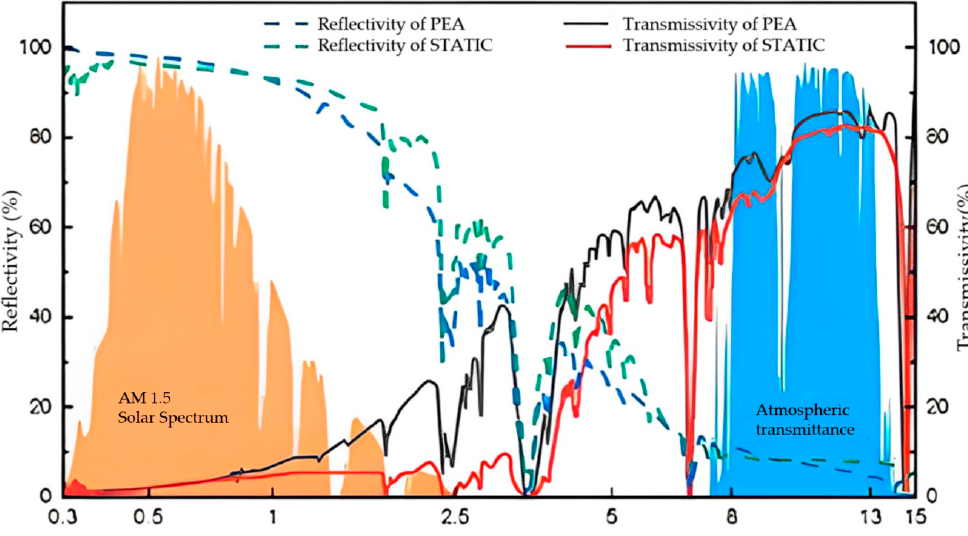
Figure 38. PEA and STATIC transmissivity and reflectivity